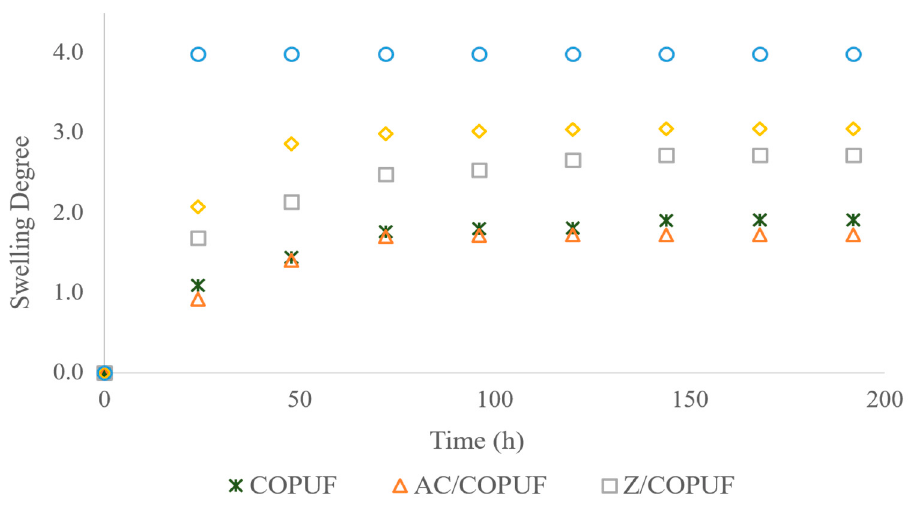
Figure 5. Swelling degree profile of COPUF, AC/COPUF, Z/COPUF, B/COPUF, and commercial PUF (CPUF).